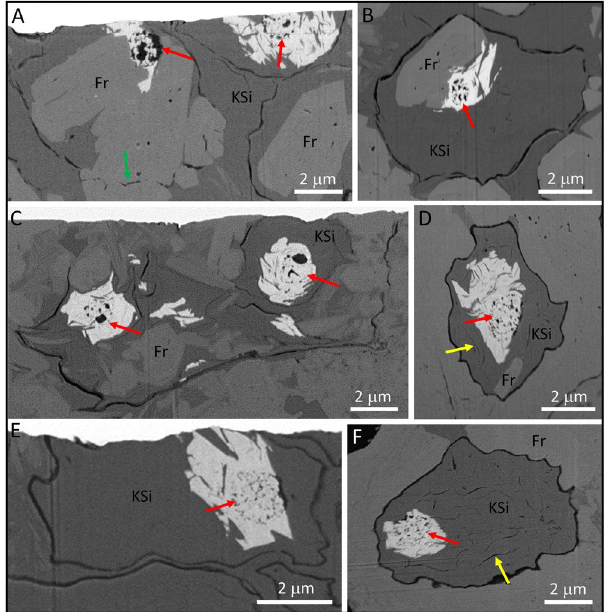
Figure 4. SEM-BSE images of the details of cells containing REE phosphate. ( A , B ) Three cells within an open cluster that contain REE phosphate (white) associated with spheroidal organic ICIs (red arrows), plus occasional wisps of black organic material preserved in francolite or clay minerals. Note how large francolite grains disrupt the cell wall in A (green arrow). ( C ) Two cells from the organism illustrated in Fig. 2E that contain multiple organic ICIs (black material) arranged in a roughly spheroidal pattern and associated with monazite (red arrows). ( D , F ) Two cells from the cluster illustrated in Fig. 2A with beaded spheroidal masses of black organic material mostly preserved in REE phosphate (red arrows), plus numerous curvi-linear organic microstructures preserved in clay minerals (yellow arrows). ( E ) A cell from the cluster illustrated in Fig. 2F showing a well- defined beaded spheroidal organic microstructure preserved mostly in REE phosphate (red